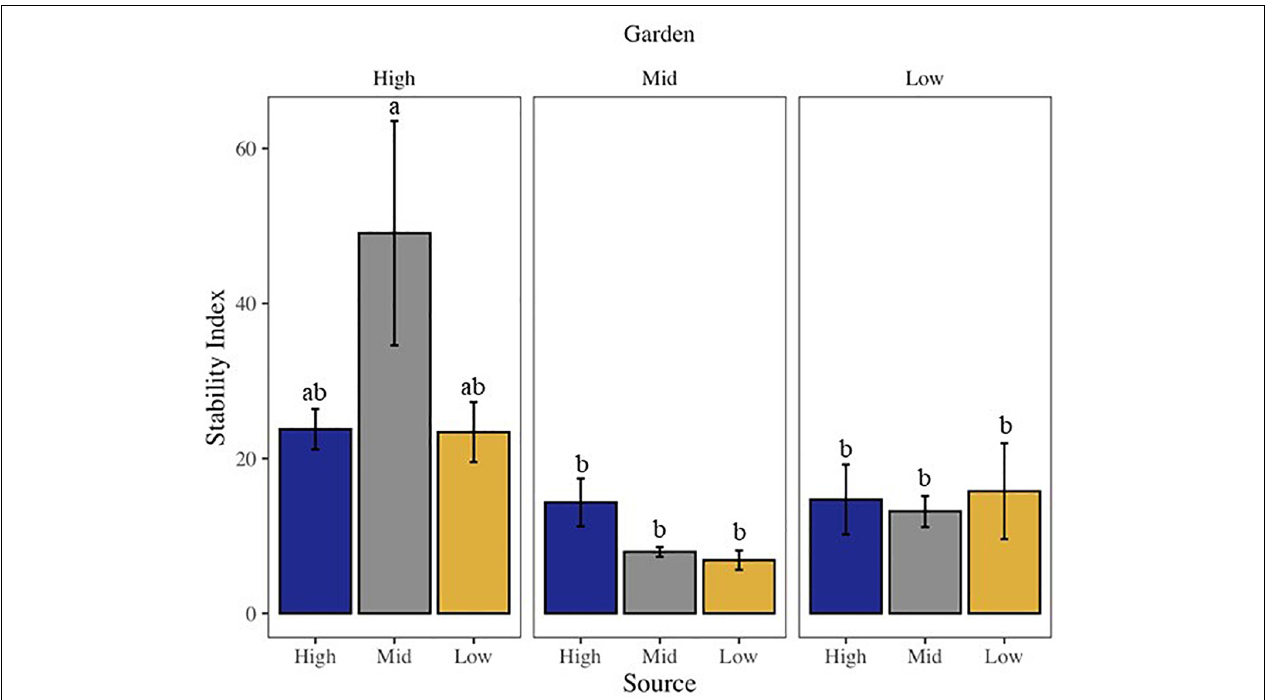
FIGURE 2 | Bar chart of community stability of the visible biocrust community, where higher values indicate greater community stability. Letters above bars indicate differences at p < 0.05 with post-hoc Tukey’s HSD